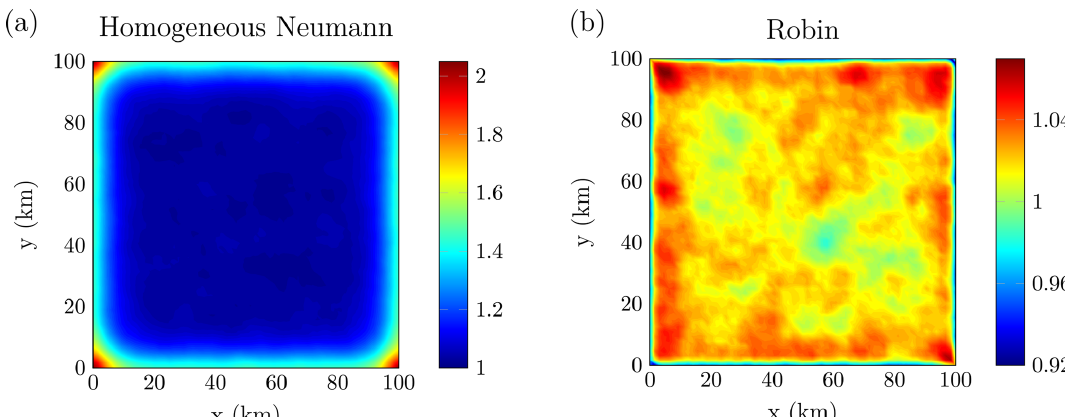
Figure 3. Comparison of estimated marginal standard deviations with homogeneous Neumann boundary conditions (a) and Robin boundary conditions (b) with the Robin coefficient given by β = (κτ)/ 1 .